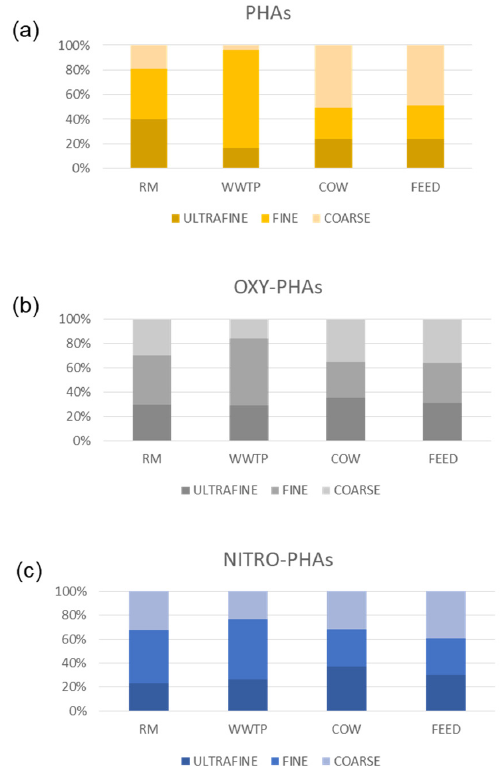
Figure 9. Percentage distribution of carcinogenic risk from PAHs ( a ), OXY- ( b ) and NITRO-PAHs ( c ) in ultrafine, fine and coarse fraction of PM in the four sampling sites.